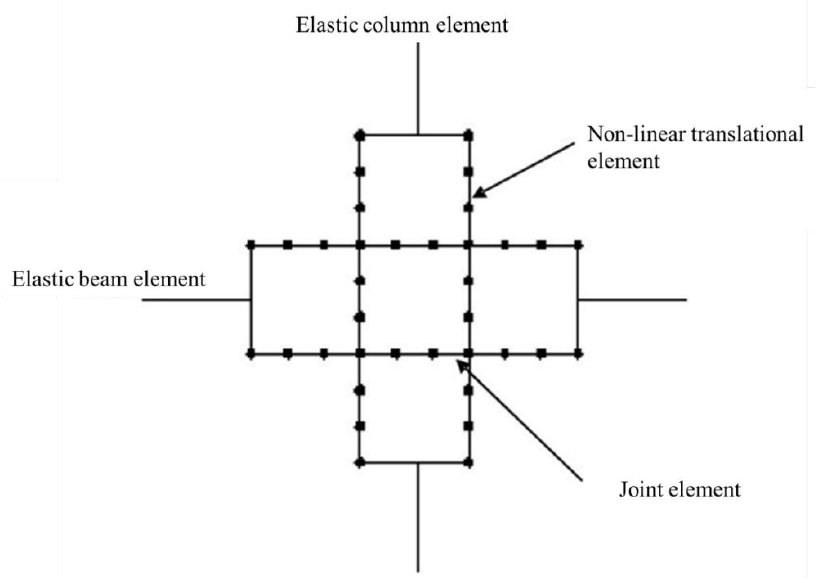
Figure 8. Elastic beams and columns connected to the joint through non-linear translational springs, based on literature [55].